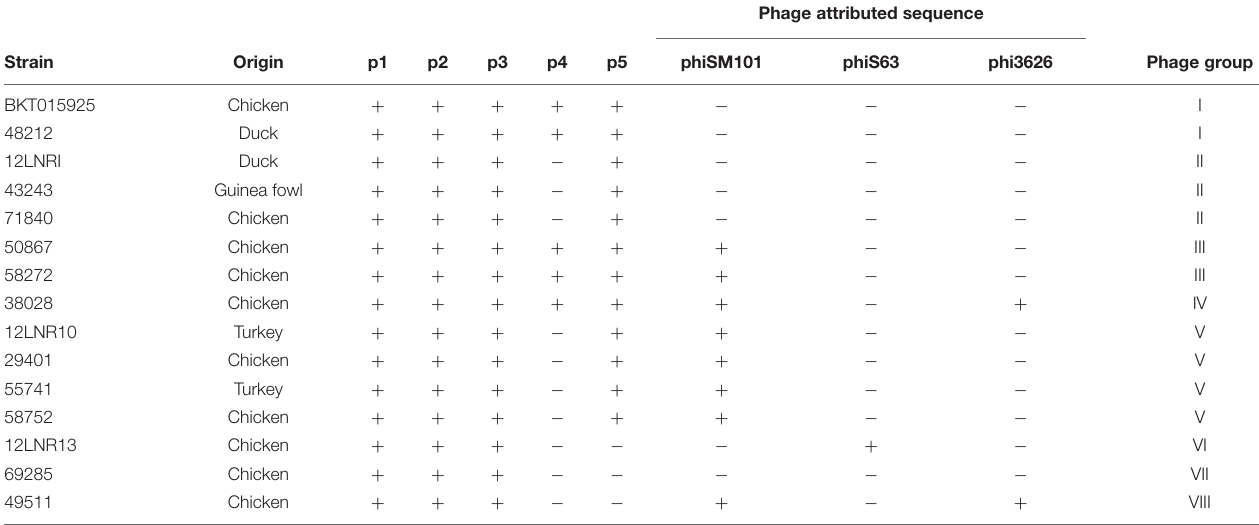
TABLE 2 | C. botulinum type C/D genetic mobile element ID card.